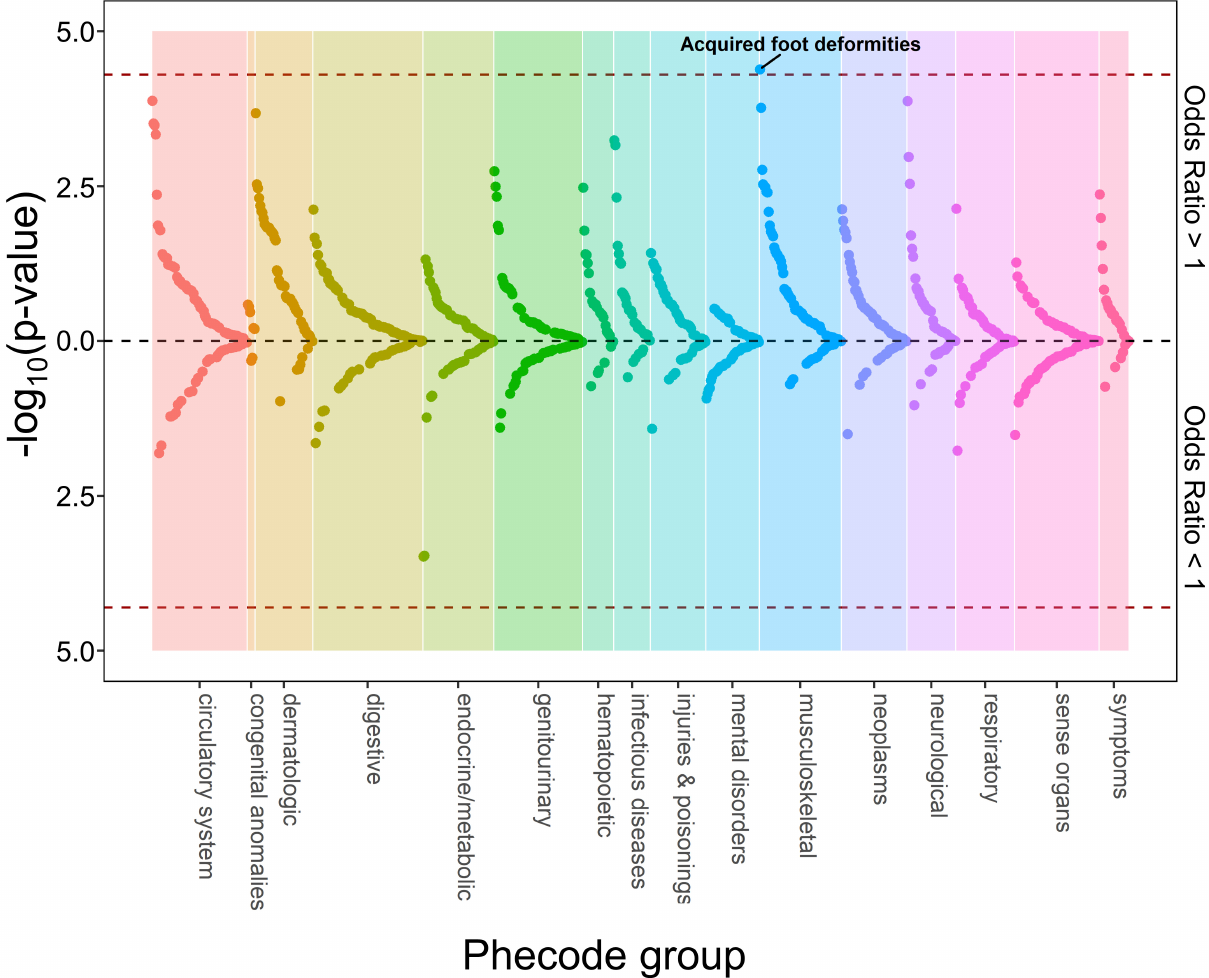
Fig 3. Phenome-wide associations with genetically predicted height in non-Hispanic Black individuals. Plot of phecodes versus -log 10 (p-value) for association with genetically-predicted height in non-Hispanic Black participants in MVP. Phecodes were limited to single decimal place for clarity (e.g., 427.2 for atrial fibrillation or flutter is shown but 427.21 for atrial fibrillation is not). Associations with a negative beta coefficient (i.e., odds ratio < 1) are plotted below the x-axis, and those with a positive beta coefficient (i.e., odds ratio > 1) are plotted above the x-axis. Red dotted lines indicate race/ ethnicity-specific phenome-wide significance thresholds ( p < 5.0E-5 for non-Hispanic Black). The top association (lowest p-value) within each phecode group is labeled.